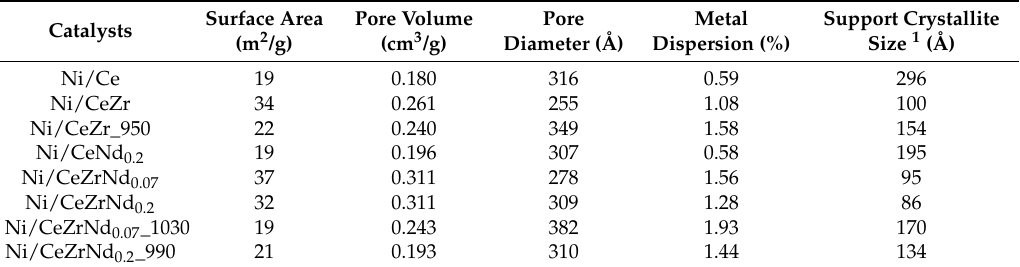
1 calculated with Scherrer equation from (111) peak of cubic phase of CeO Table 2. Morphological and structural properties of the